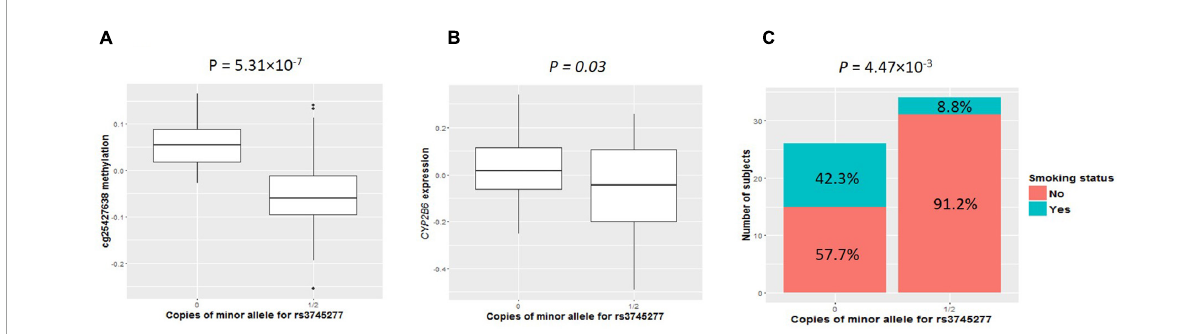
FIGURE1 Comparisons of cg25427638 methylation, CYP2B6 expression, and smoker percentage between subjects with zero copies of rs3745277 minor allele and those with either one or two copies. The two boxplots indicate methylation at cg25427638 (A) and expression for CYP2B6 (B) for subjects with 0 or 1/2 copies of rs3745277 minor allele. (A) Student’s t -test results are included. Because of the existence of outliers, as shown in the top panel, robust statistical methods were implemented to confirm the t -test results. The barplot in (C) illustrates smoker and non-smoker percentages for each genotype. Fisher’s exact test was performed to obtain the p -value for this panel. All the p -values are significant ( P < 0.05).